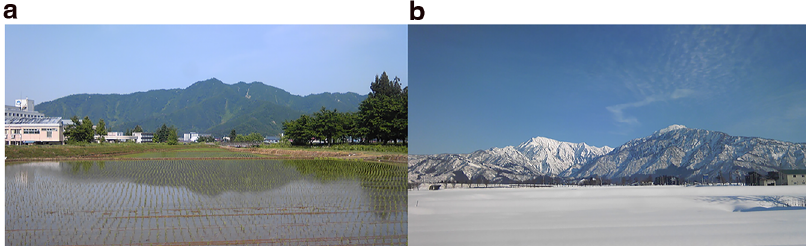
Fig. 1 Seasonal landscapes of the Uonuma area of Niigata Prefecture, Japan. Uonuma area in a the green season and b the snow season.